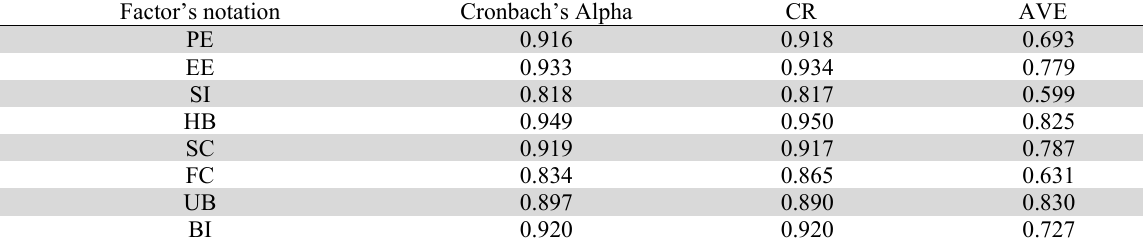
Composite reliability (CR) and average variance extracted (AVE) Factor’s notation